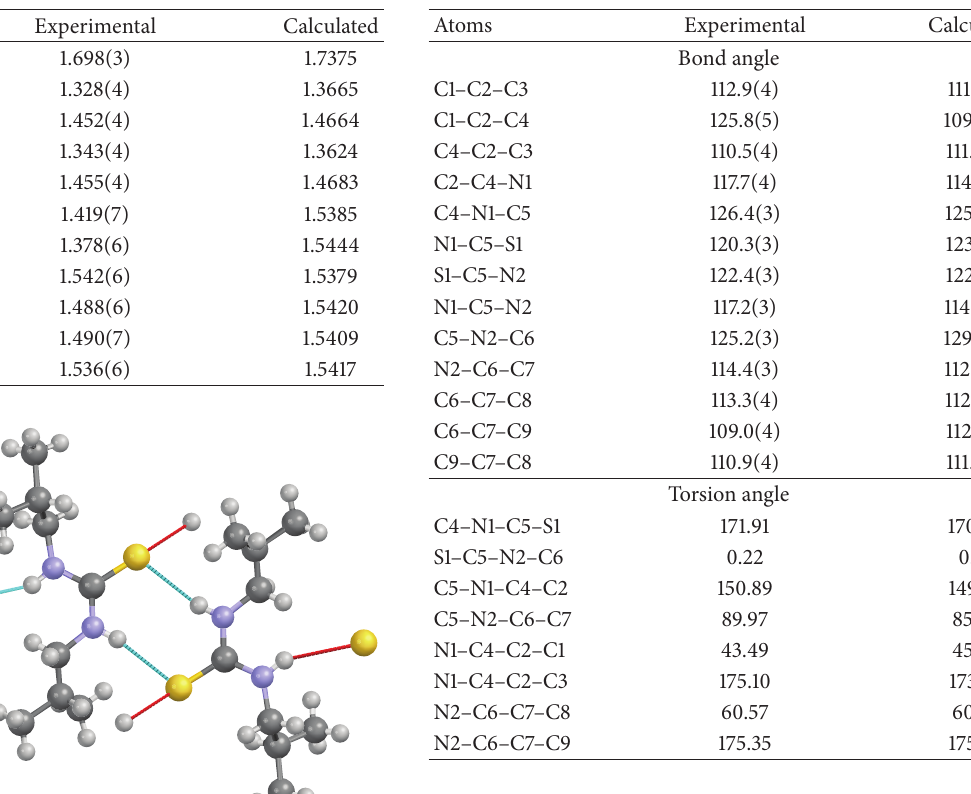
Table 4: Selected bond angles and torsion angles for compound 1 , a comparison between experimental and theoretical